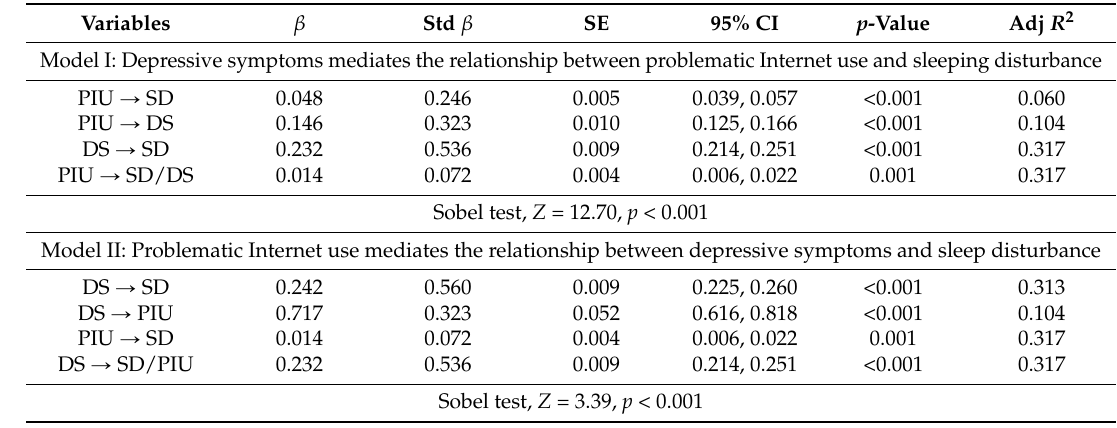
Table 4. Multiple regression models for testing the relationships between problematic Internet use, sleep disturbance and depressive